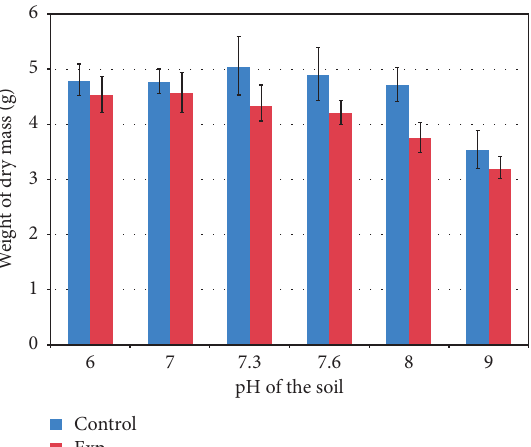
Figure 4: Change in the weight of dry biomass of P. oleracea in the absence (control) and presence (Exp) of chromium as the pH of soil increases (mean of six replicates ± SE, 95% CLs).